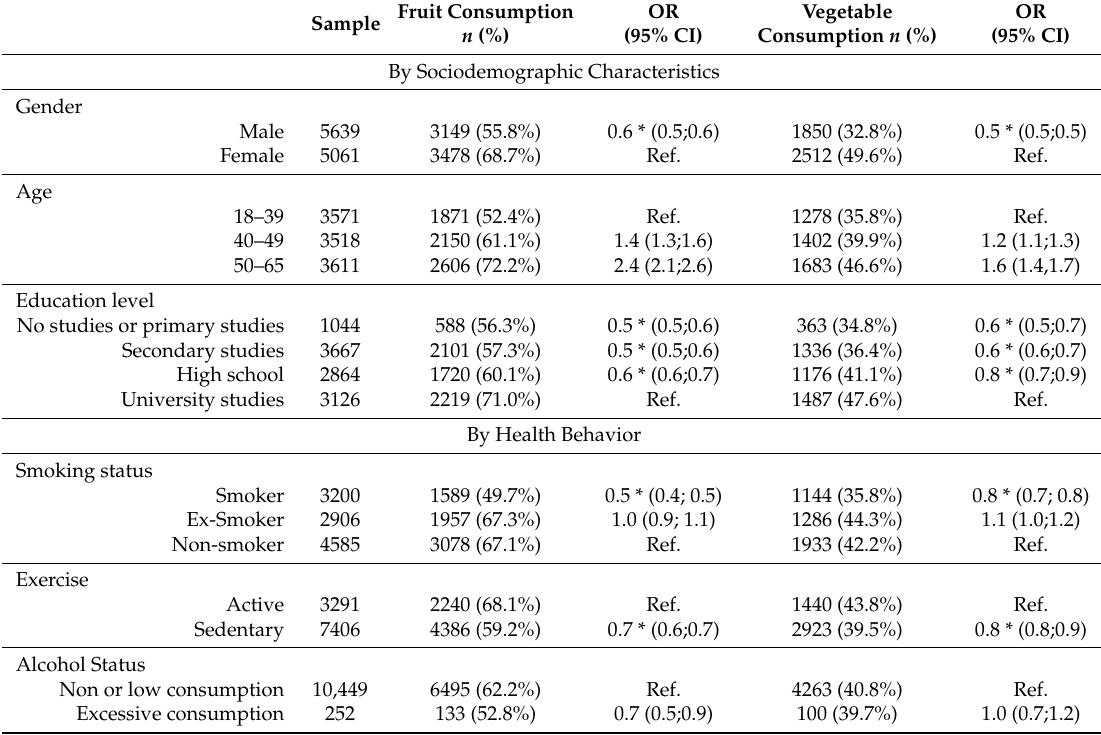
Table 1. Daily consumption of fruit and vegetables by sociodemographic characteristics and health